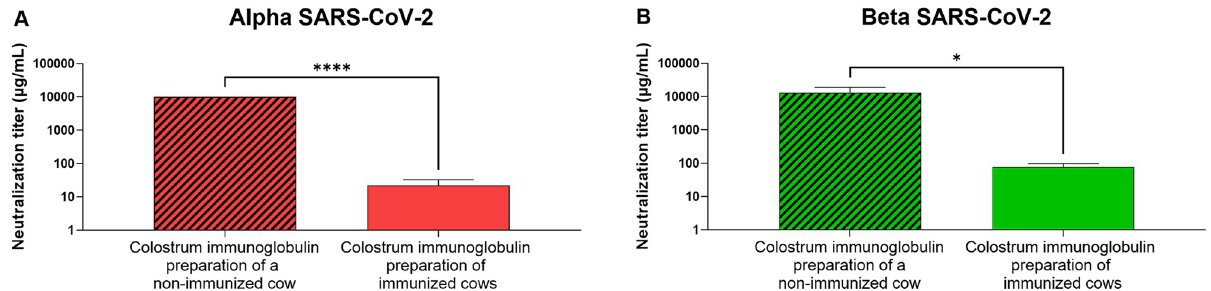
Fig 4. The neutralizing activity of the colostrum immunoglobulin preparation on SARS-CoV-2 infection analyzed by cytopathic effect reduction. Colostrum-derived immunoglobulins from a nonimmunized cow and from SARS-CoV-2 S protein-immunized cows were added to (A) Alpha and (B) Beta SARS-CoV-2 virus isolates at different concentrations and then transferred to Vero E6 cells, which were grown for 4–5 days. The neutralization activity was defined by the endpoint method, i.e., determination of colostrum immunoglobulin preparation concentrations blocking infection of Vero E6 cells. Data are represented as the mean ± SD (n = 3). The unpaired t test was performed; Alpha: ���� p < 0.0001, Beta: � p =